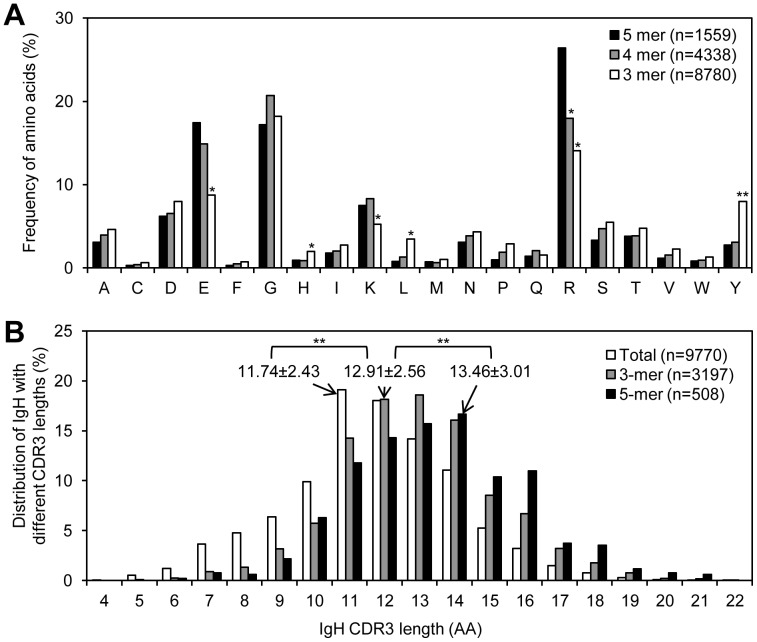
Comparison of the amino acids encoded by VH replacement footprints and the IgH CDR3 lengths of VH replacement products.(A) The usages of different amino acids encoded by VH replacement footprints with 5, 4, or 3 nucleotides were compared. n, number of amino acid residues encoded by the identified VH replacement footprints with different lengths. Statistical significance was determined using a two-tailed Chi square test with Yate’s correction. p<0.05 (*) is considered significant and p<0.0001 (**) is considered extremely significant. (B) Comparison of the IgH CDR3 lengths of VH replacement products containing the 5-mer or the 3-mer VH replacement products with the CDR3 length of the total functional IgH genes. n, number of IgH sequences or VH replacement products with 3- or 5-mer VH replacement footprints. Statistical significance was determined using unpaired t test. p<0.05 (*) is considered significant and p<0.0001 (**) is considered extremely significant.